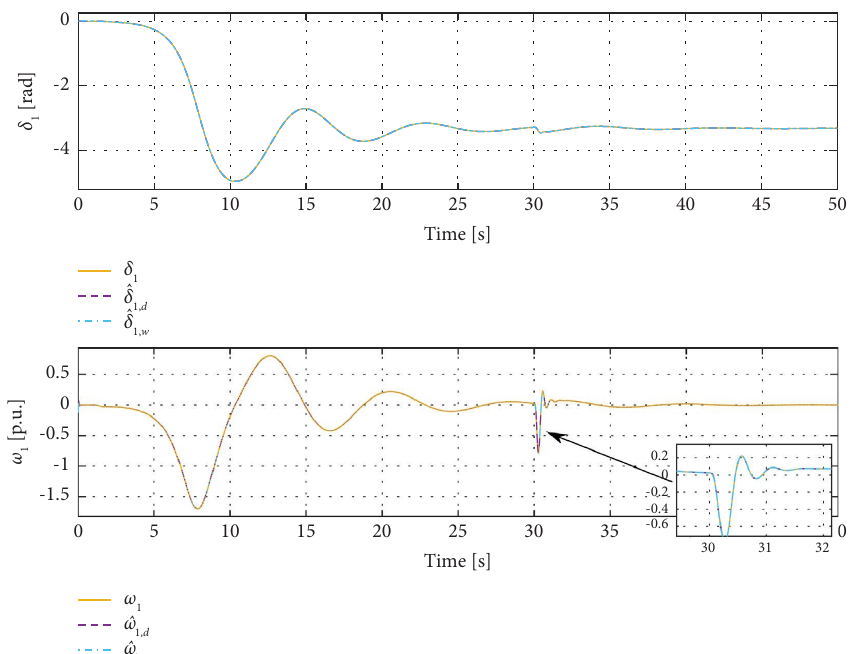
Figure 2: Comparison between the L-D GE estimators: load angle and relative speed of generator one.